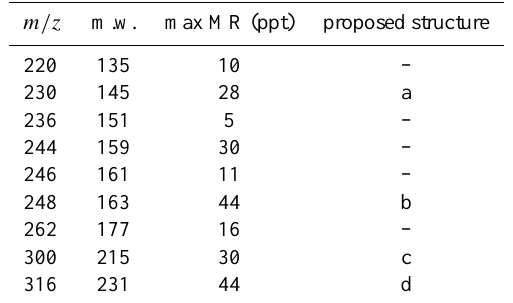
Table 2. Significant nitrogen-containing m/z observed with the CIMS. The m/z column indicates the signal in the mass spectrum. The m.w. column is the inferred molecular weight ( m/z − 85). The letters in the proposed structure column designated the correspond- ing structures shown in Fig.